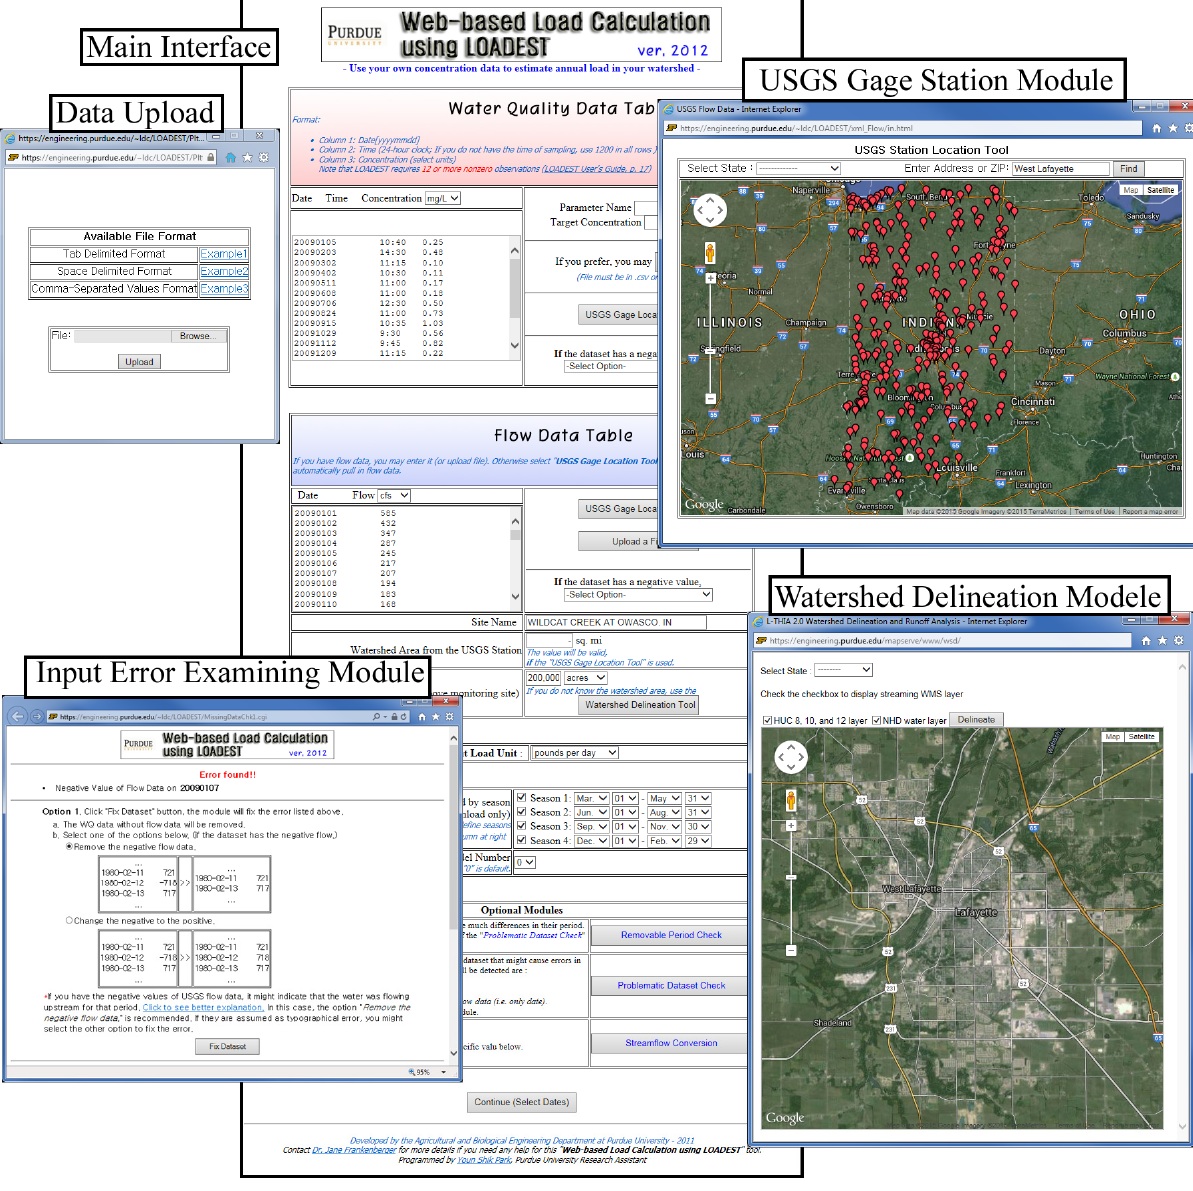
Figure 1. Web interfaces of LOADEST